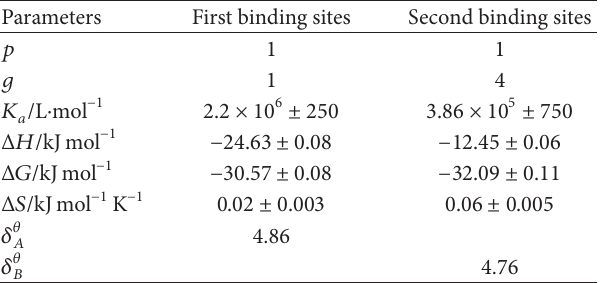
F 2: Comparison between the experimental heats ( ) at 300K, for (sulfonamide + HSA) interactions and the calculated data (lines) via (1). ▵ T 1: Binding parameters for HAS + sulfonamide interaction. e interaction is both enthalpy and entropy driven, but the electrostatic interactions are more important than hydrophobic values show that sulfonamide in the second class of forces. binding sites has higher affinity for binding than the �rst class of and indicate that the binding sites. e positive values of 𝐾𝐾 𝑎𝑎 antioxidant property of HSA increased as a result of its interaction 𝜃𝜃 𝜃𝜃 𝐴𝐴 𝐵𝐵 with sulfonamide. 𝛿𝛿 𝛿𝛿